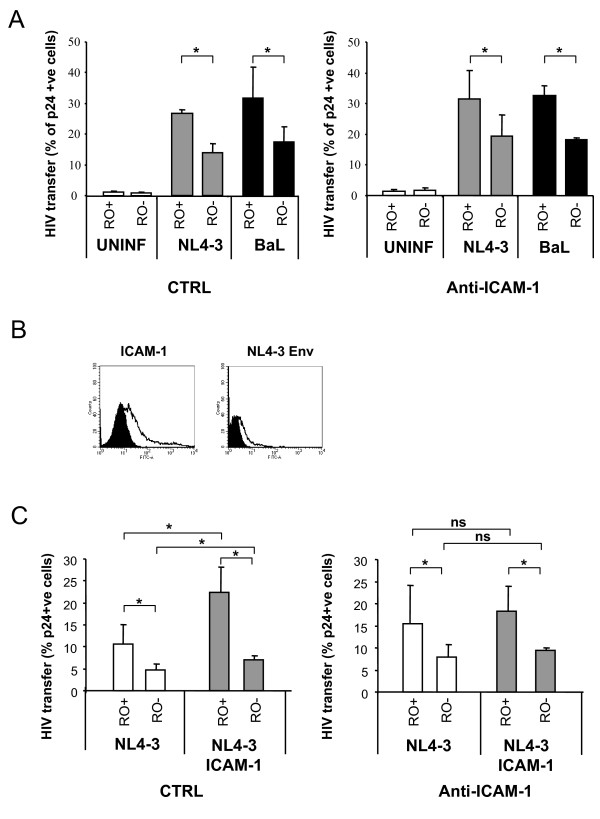
Preferential LFA-1-independent transfer of HIV particles to CD45RO+ cells during T cell-T cell synapses. Panel A. MOLT cells chronically infected with NL4-3 (grey bars) and BaL (dark bars) viruses or left uninfected (white bars) were cultured with purified primary CD4 T cells. After 2 h of coculture, cells were stained with anti-CD45RO and anti-HIV p24 antibodies. Analysis of HIV transfer in the absence (left graph) or presence (right graph) of the RM3A5 blocking mAb against ICAM-1 was performed after gating separately CD45RO and CD45RA CD4 T cells. Panel B shows the expression of HIV Env (right) and ICAM-1 (left) in 293T transfected cells (empty peaks), solid peaks correspond to negative controls of staining. Panel C shows HIV transfer from 293T cells transfected with an Env defective and an NL4-3 Env plasmids, to CD45RO- (RO-) and CD45RO+ (RO+) target cells in the absence (light bars) or presence (grey bars) of ICAM-1 expression. HIV transmission was again measured in the absence (left graph) or the presence (right graph) of the blocking RM3A5 antibody against ICAM-1. Values are Mean ± SD of 3 experiments performed with CD4 T cells from 3 different donors. Asterisks denote significant differences in HIV transmission to the CD45RA CD4 T subset compared to CD45RO cells (Panel A and C). Significant differences intrasubsets induced by ICAM-1 expression are also indicated by asterisks in panel C, while ns denotes no statistical significance.